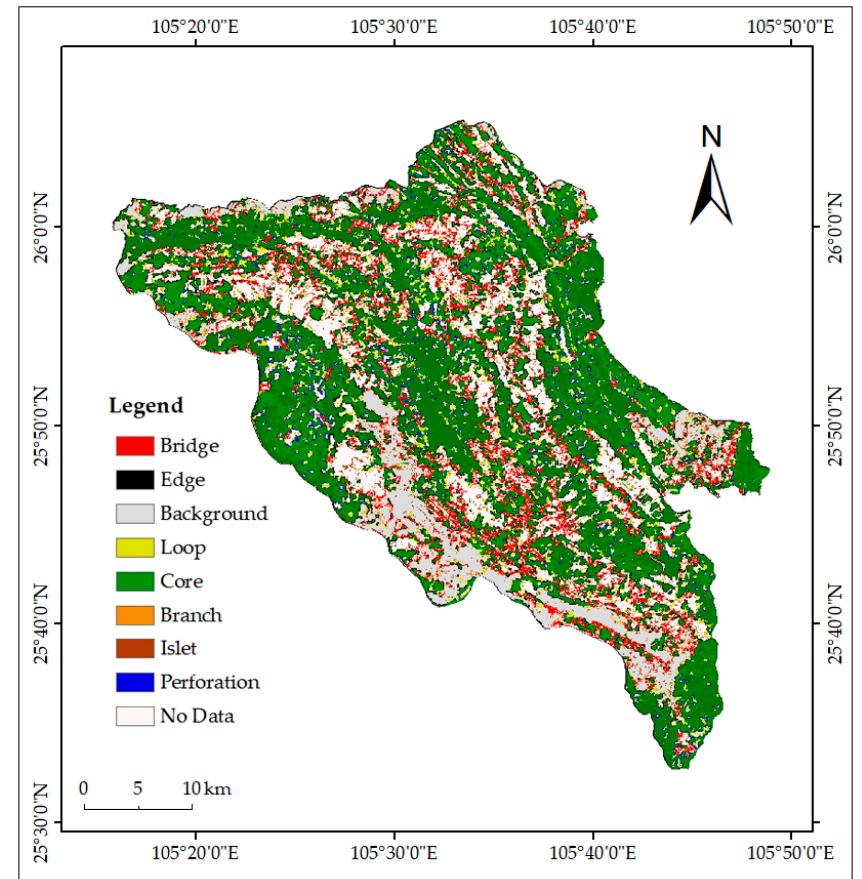
Figure 5. MSPA landscape type map of Guanling County. Table 5. Landscape types in Guanling County.